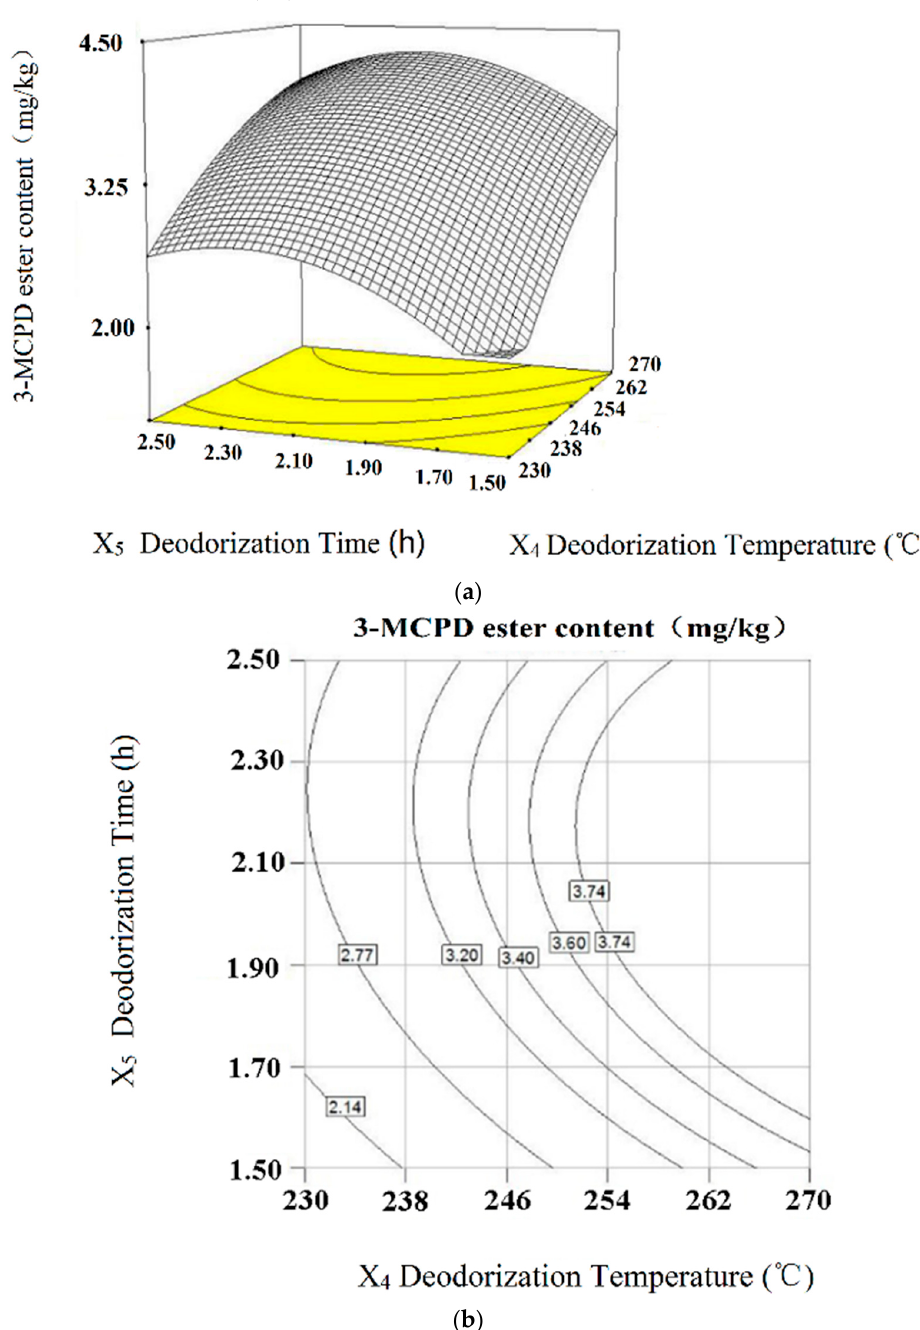
Figure 6. Response surface curves ( a ) and contours ( b ) of deodorization time and deodorization temperature towards 3-MCPD ester (interactions of X 4 X 5 , p > 0.05).